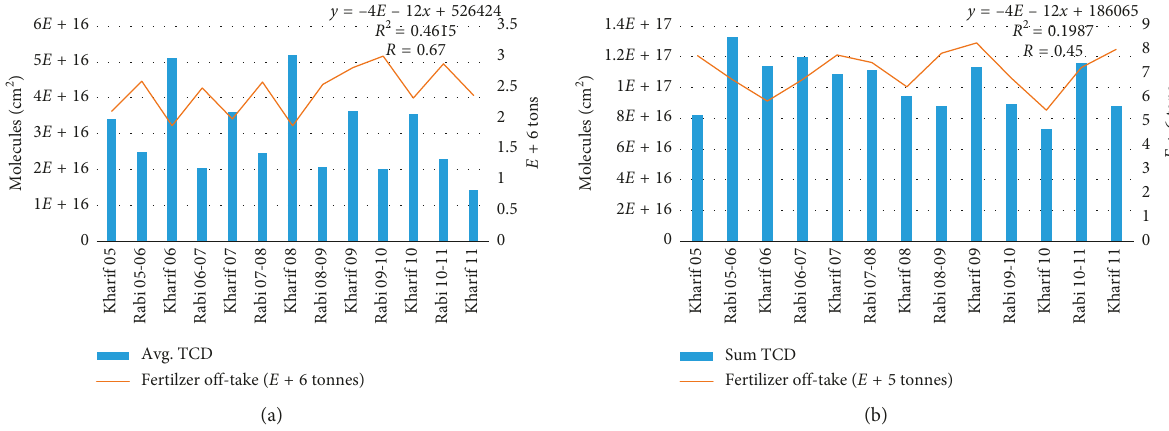
Figure 9: Total column density of ammonia (molecules/cm 2 ) versus total fertilizer offtake (tons) as obtained from the National Fertilizer Development Centre, Pakistan, for the provinces majorly falling under the IGP. (a) Punjab. (b)